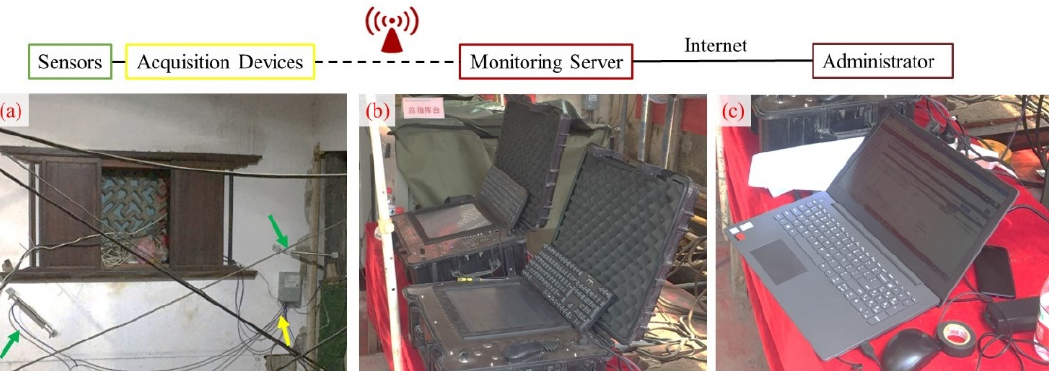
Figure 3. Four kinds of sensor nodes used: ( a ) inclinometer, ( b ) displacement transducer, ( c ) series inclinometer, and ( d ) strain gauge.